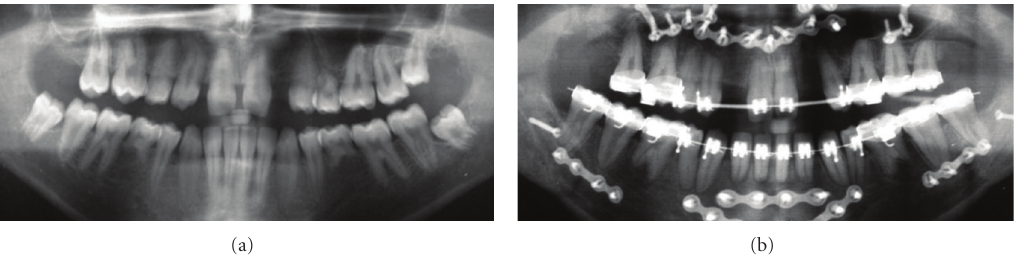
Figure 5: (a) OTP (15 years) showing agenesis of 18 and 15,12, 22, 23, 25, 35, 45; hypoplasia of the crowns of the upper central incisors in patient 3. (b) Severe root resorptions of the lower incisors and the lower first molars in patient 3 after correction of the skeletal Class III relationship by means of combined orthodontic-orthognathic therapy.